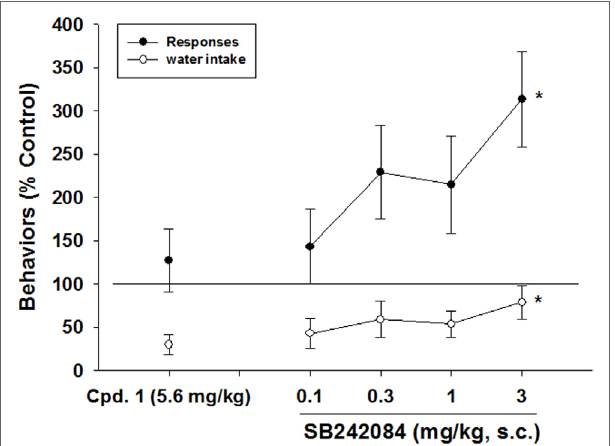
FigUre 6 | effects of 5-hT 2c receptor antagonism on the reductions in schedule-induced polydipsia produced by cPD 1 . SB- 242084prevented the decreases in excessive water consumption produced by CPD 1 (5.6 mg/kg) ( F 4,25 = 6.0, p < 0.001) and significantly enhanced the number of responses emitted ( F 4,25 = 3.1, p < 0.05). Each point represents the mean ± SEM of 6 rats/group. * p < 0.05 compared to vehicle (Dunnett’s